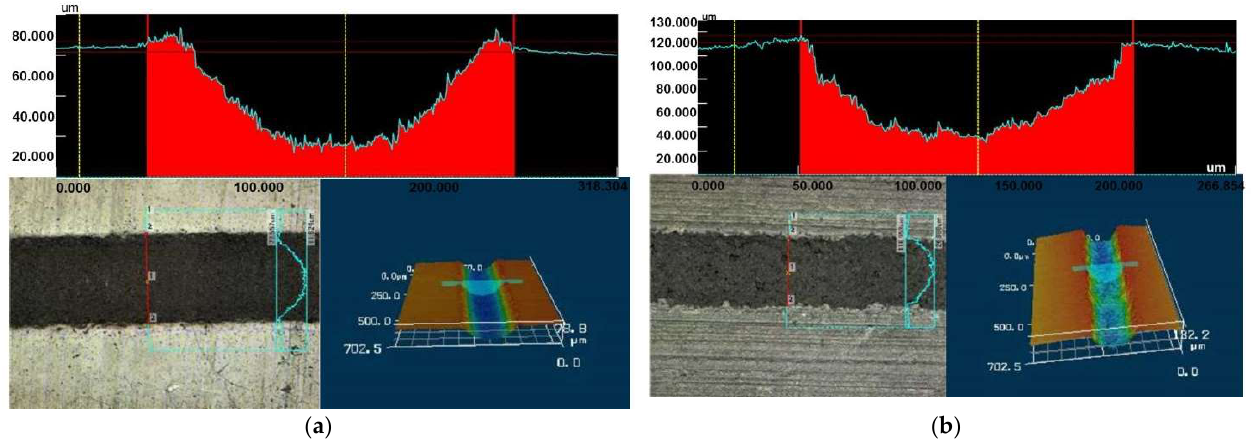
Figure 7. 3D Laser microscope views of the tracks produced by: ( a ) 266 nm laser pulses with fluence 42.66 J.cm −2 ; and ( b ) 355 nm laser pulses with fluence 37.68 J.cm −2 . It can be seen no debris are re-deposited after laser ablation near the tracks. HAZ also is not formed.